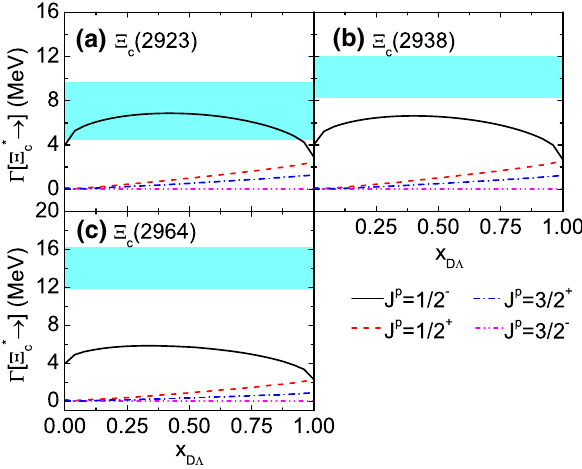
Fig. 4 The total decay width with different spin-parity assignments for the various (cid:2) ∗ c as a function of the parameter X D (cid:3) . The cyan band denotes the experimental total width [2]